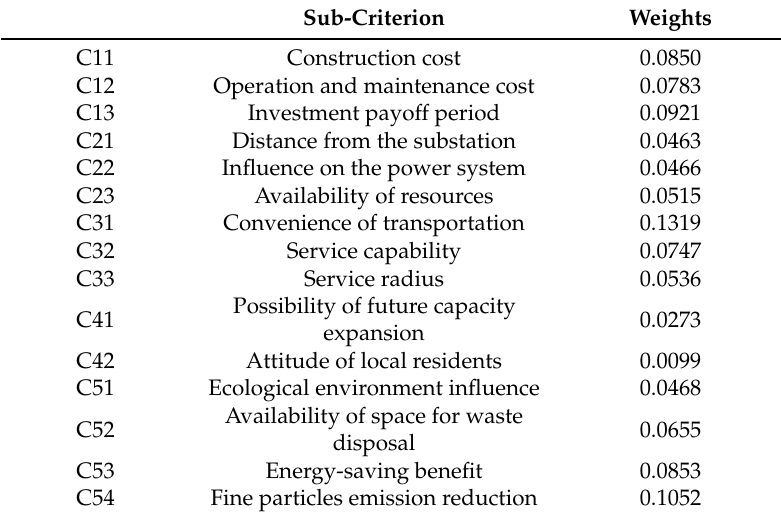
Table 5. The weights of the criteria.